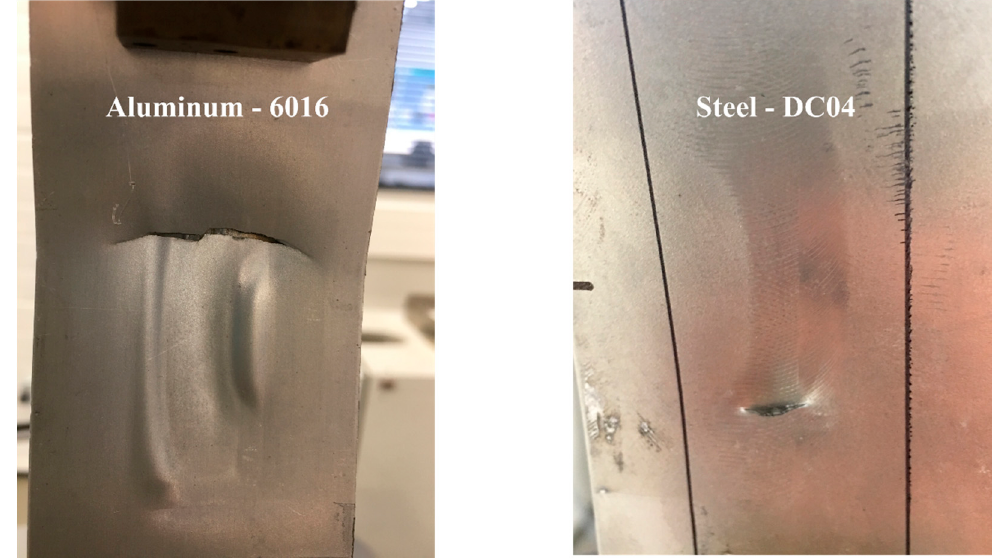
Figure 17. Aluminum 6016 and steel DC04 tearing during fatigue tests